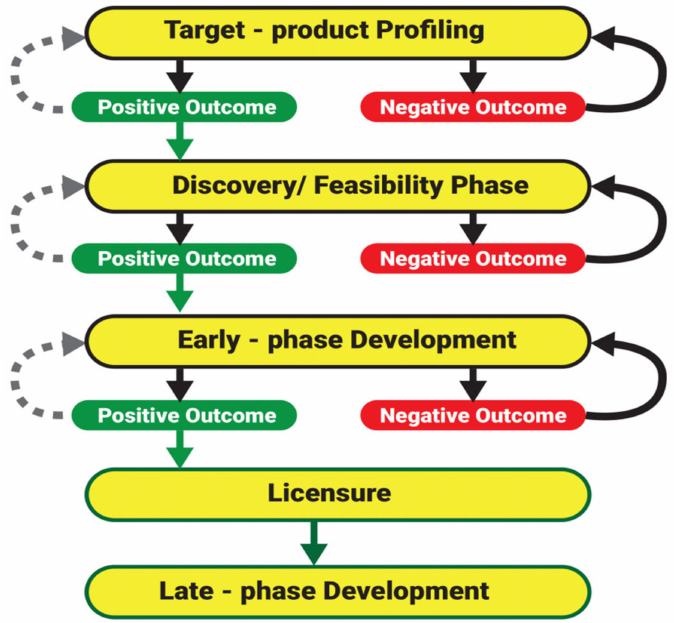
Figure 6. A flow chat for anti-tick vaccine development. Depending on whether the outcome is positive or negative, the phase studies may be repeated as shown in the curved